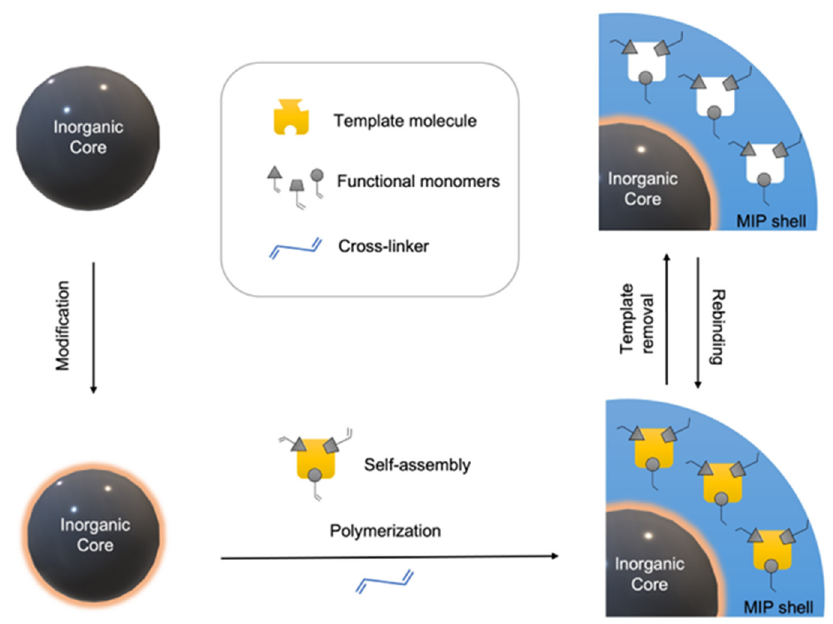
Figure 1. Illustration of molecularly imprinted polymer shell coating onto an inorganic core.